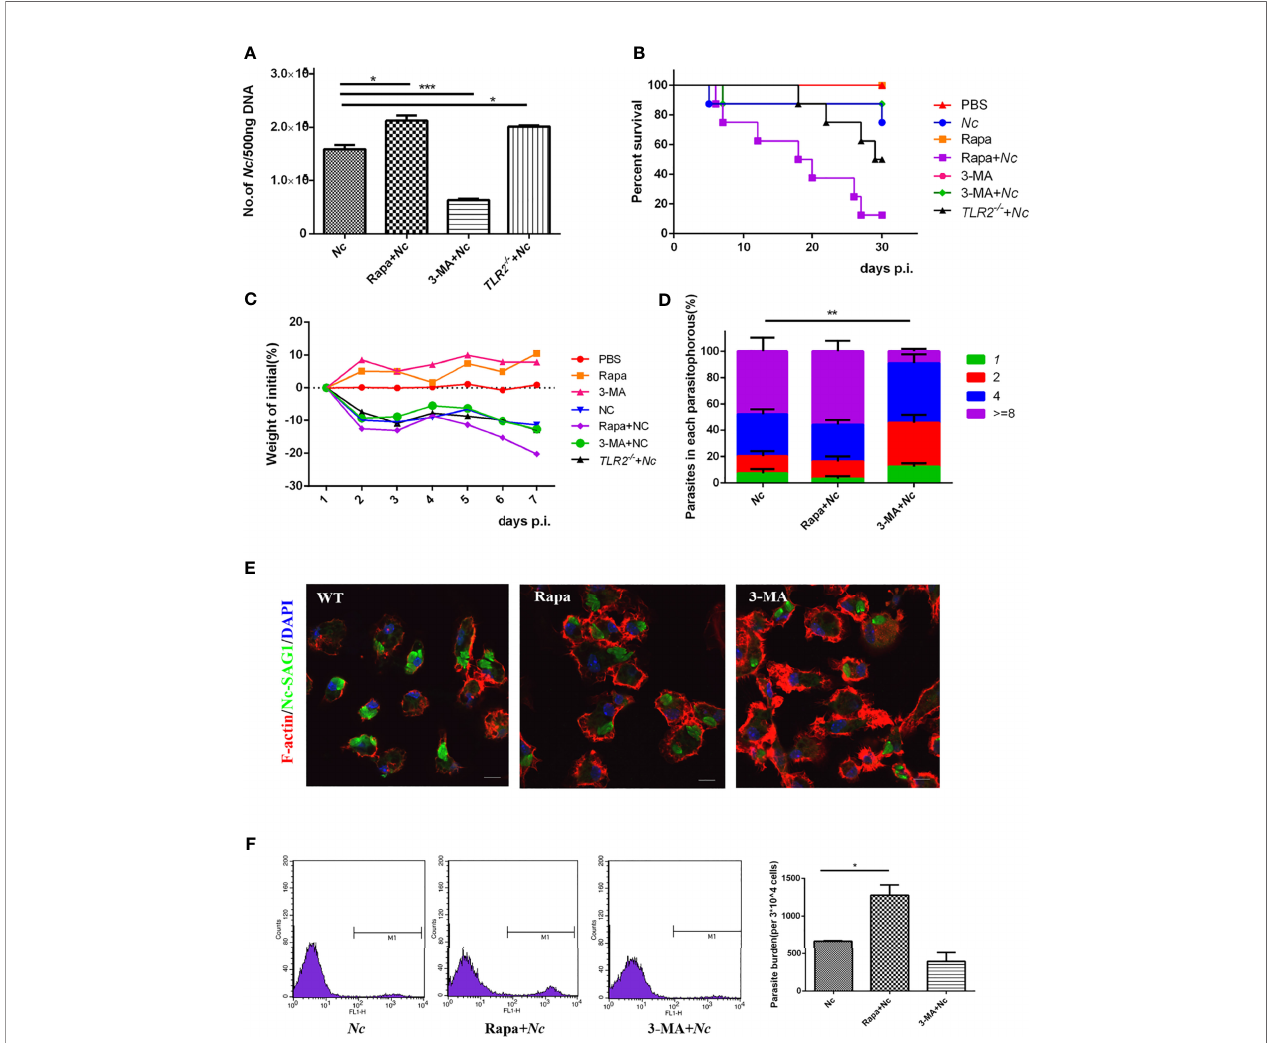
FIGURE 5 | Roles of autophagy in host resistance to N. caninum infection. PMs were infected with N. caninum at MOI of 1 in the presence or absence of rapamycin (1 m M) or 3-methyladenine (3-MA) (2.5 mM) for 24 h. (A) The number of parasites in each group was detected by quantitative PCR. Female C57BL/6 mice were infected with 2 × 10 7 N. caninum tachyzoites in the absence or presence of either Rapa or 3-MA and were monitored daily. (B) Survival of mice was monitored for 30 days. (C) Weight of mice was recorded daily within 7 days of infection. (D) Quanti fi cation of parasites in vacuoles in each group was monitored by fl uorescence microscopy. (E) PMs were stained with polyclonal antisera against NcSAG1 and used to visualize N. caninum , and confocal microscopy was used to observe them. (F) Female C57BL/6 mice were intraperitoneally injected with 2 × 10 7 of GFP- Nc ; rapamycin (1 mg/kg/day) or 3-MA (15 mg/kg/day) was injected intraperitoneally 1 day after infection. Seven days later, peritoneal exudate cells were detected by fl ow cytometry. The data are expressed as the mean±SEM from three separate experiments, *P<0.05; **P<0.01;